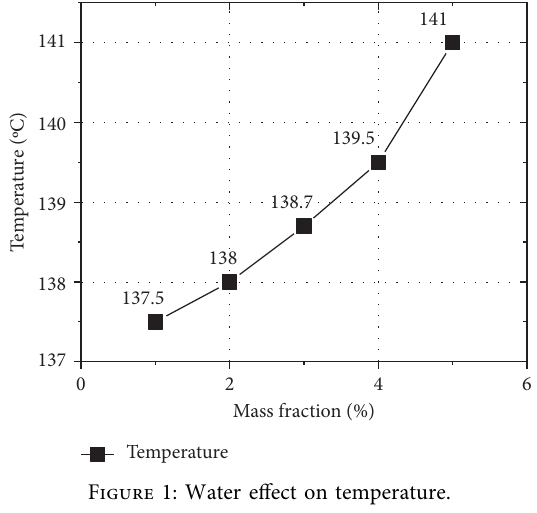
Figure 1: Water effect on temperature.